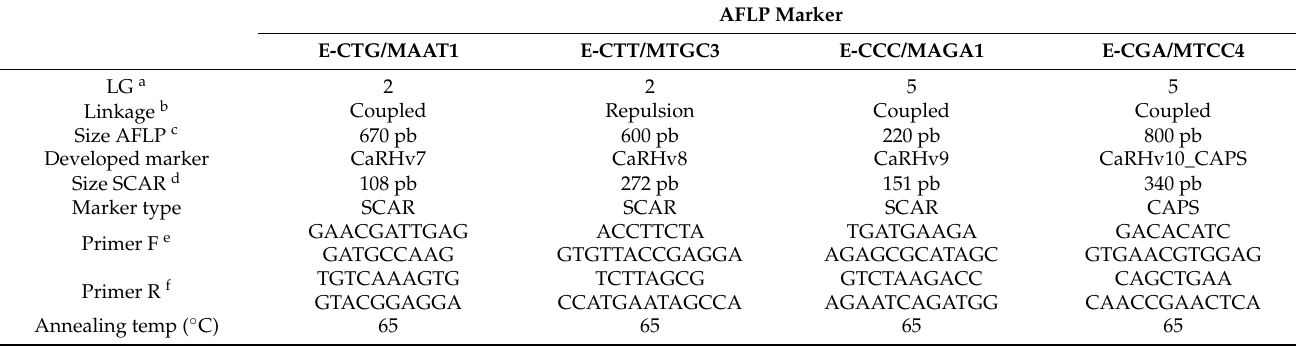
Table 1. AFLP primers linked to the resistance locus and their respective SCAR and